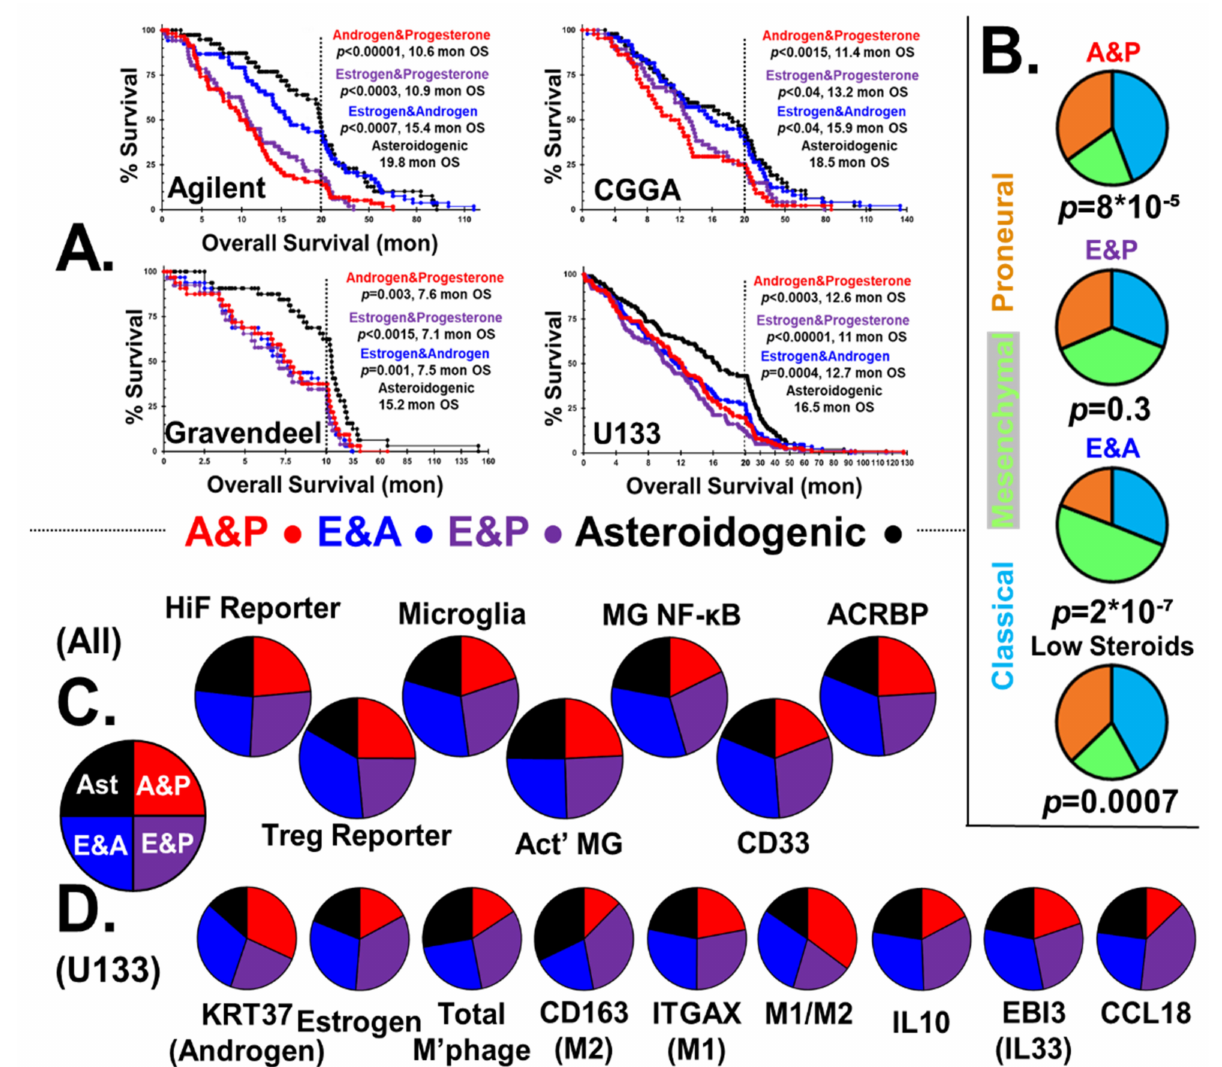
Figure 3. GBM Patient Sex Steroid synthesis: Outcome and Characteristics. ( A ) Kaplan–Meier survival curves of GBM patients with tumors stratified by high androgen/progesterone; low estrogen (red), high estrogen/progesterone; low androgen (violet), high estrogen/androgen production; low progesterone (blue), and overall low steroid production, asteroidogenic (black). All p -values are statistically significant compared to the low group. ( B ) CMP subtypes of GBMs correlate with androgen, estrogen and progesterone expression. ( C ) Data from all four databases in the form of pie charts indicating the amount of steroidal influence on seven markers of interest, all statistically significant at p < 0.05 except microglial activation. Estrogenic GBMs have elevated HiF and androgenic GBMs have infiltrating RORC-Treg reporter levels. Estrogenic GBMs are associated with microglial infiltration and NF- κ B signaling. Myeloid cell infiltration reporter CD33 tracks estrogen, with a 2:1 ratio of CD33 levels in estrogenic tumors compared with tumors with low estrogen. Sperm-specific ACRBP clearly correlates with androgenic GBM subtypes. ( D ) U133 database pie charts indicating that androgen and estrogen reporter genes track the steroidogenic stratification. Total macrophage levels are low in androgen and progesterone. Sex steroids clearly affect the M2/M1 polarization, with androgen driving M1 > M2, but estrogen driving M2 > M1. Levels of immunosuppressive IL10 and CCL18 correlate with estrogen, but EIB3 generation is inhibited by androgen. p < 0.02 in all cases utilizing t -tests. Individual t -test results are in Supplemental Table